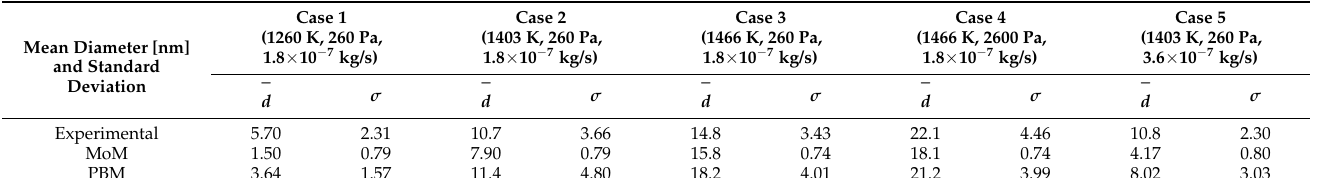
𝑑¯ Table 2. Final value of [nm] and 𝜎 for the experimental and NanoDOME calculations. Table 2. Final value of d [nm] and σ for the experimental and NanoDOME calculations.